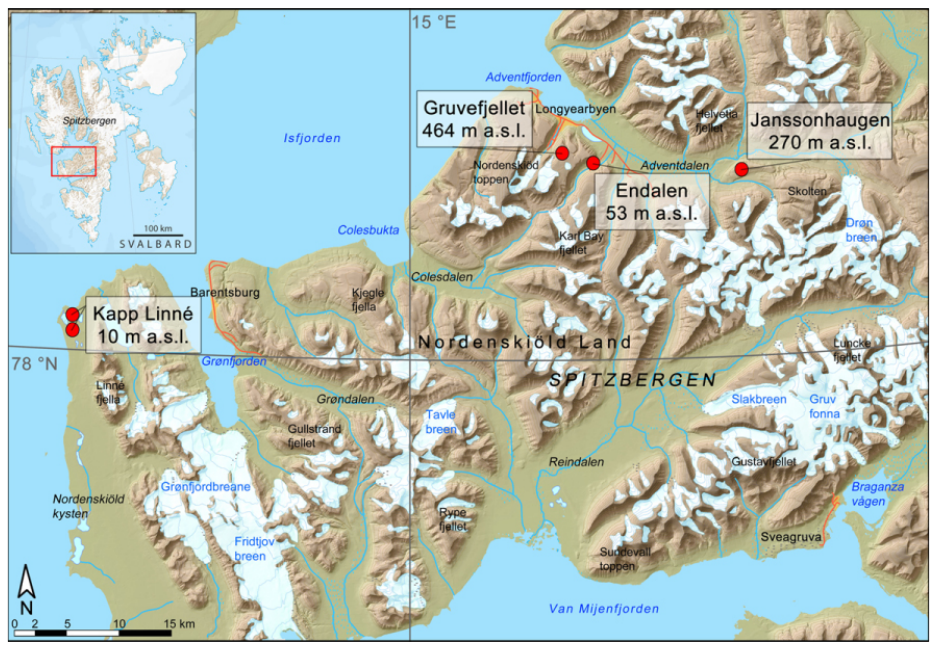
Fig. 1. Location of the studied borehole sites in Svalbard (inlet map) in the Nordenski¨oldland Permafrost Observatory (see also Juliussen et al., 2010). The selected sites for this study on the Nordenski¨old peninsula are Endalen, Janssonhaugen, Gruvefjellet and Kapp